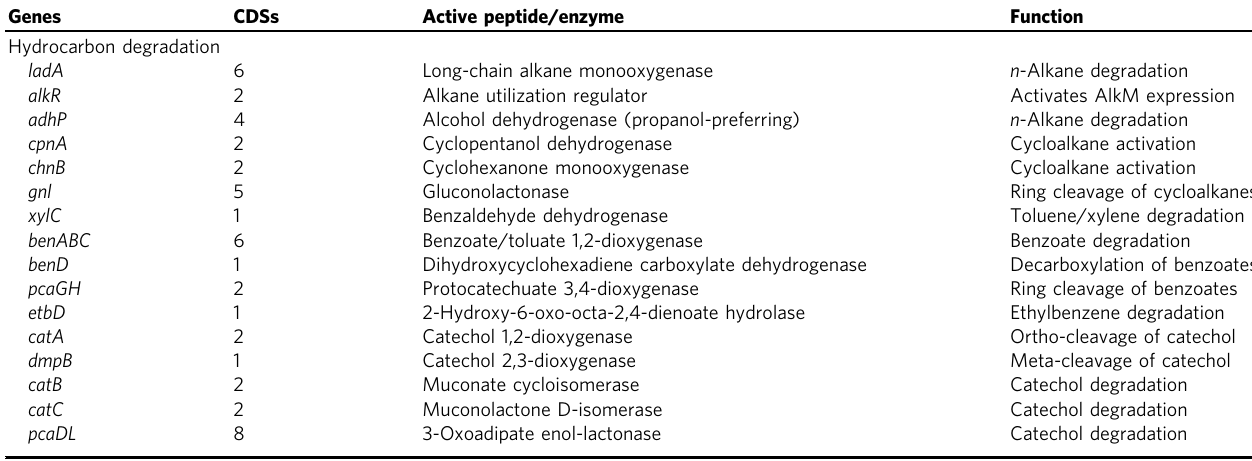
CDSs coding DNA